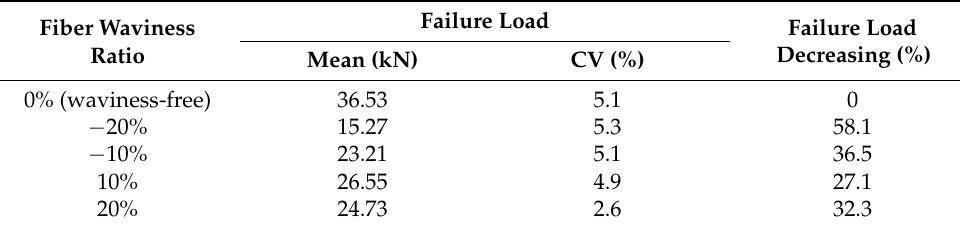
Figure 6. Compressive load-displacement curves with different fiber waviness ratio: ( a ) waviness-free, ( b ) − 20%, ( c ) − 10%, ( d ) 10%, ( e ) 20%. Table 1. Compression test